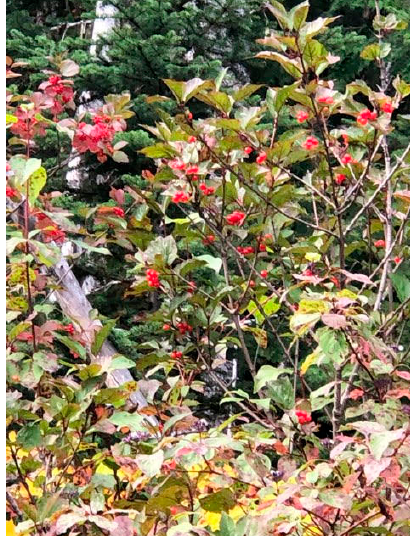
Figure 1. Wild chokecherries.